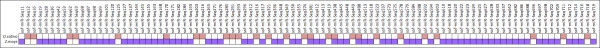
Partial conservation of new sugarcane miRNAs candidates between rice and maize. Boxes are highlighting the presence of new miRNA precursor identified by miRCat pipeline in theses plant species.